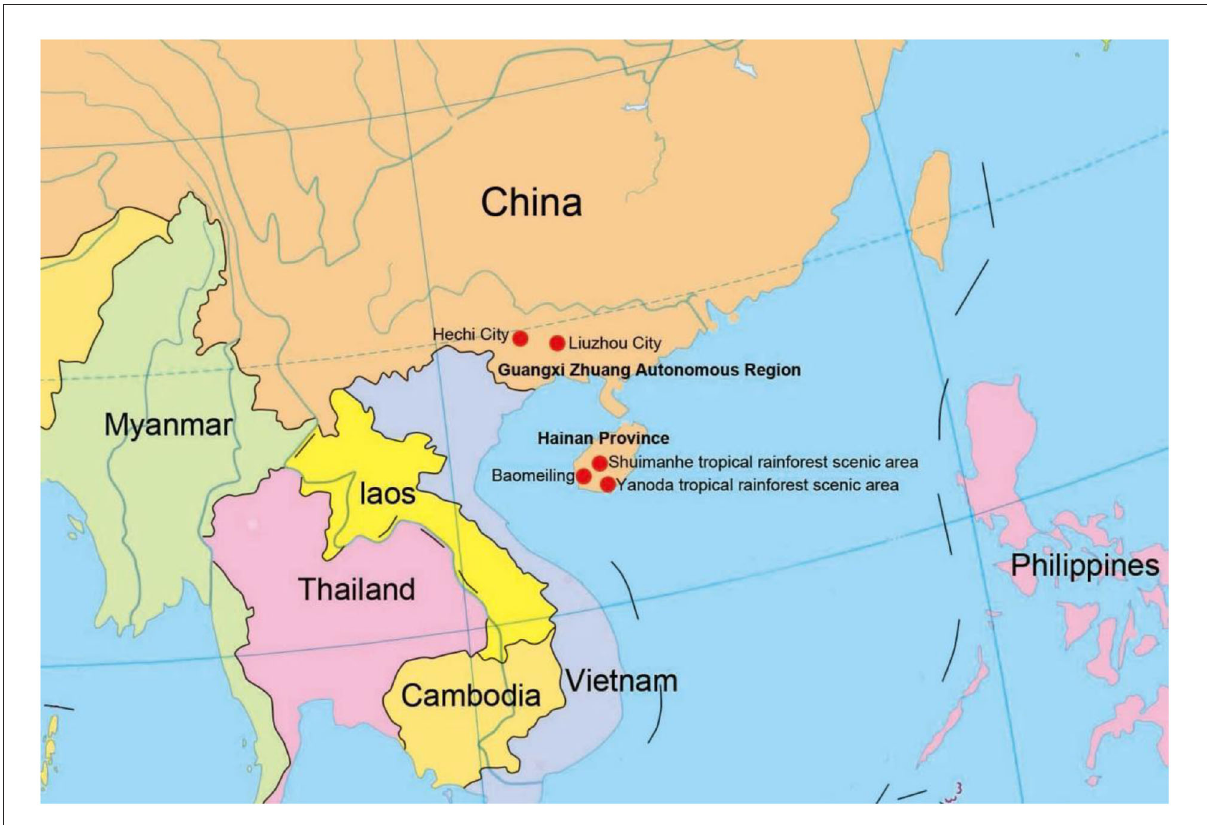
FIGURE1 Collecting sites in this study (red